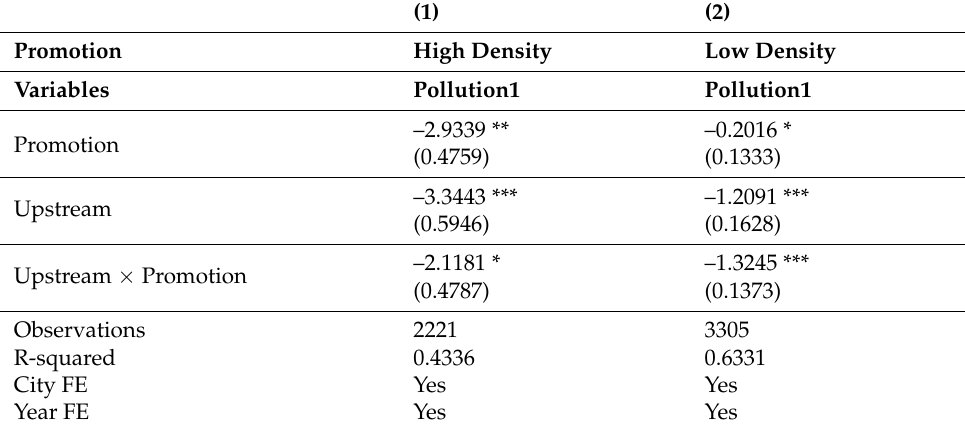
Table A5. Effects of promotion under a high and low number of